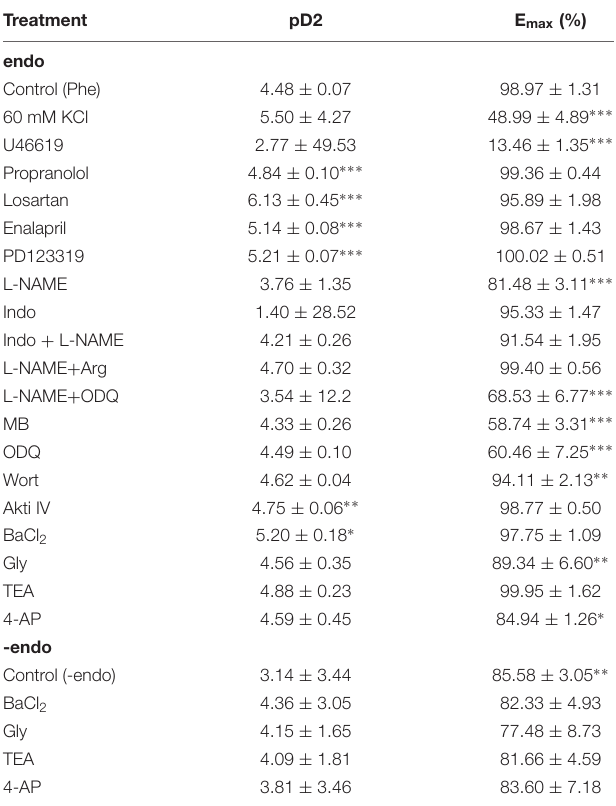
TABLE 1 | Characteristics of THP (1–100 µ M)-induced vascular relaxation under different conditions in intact (endo) and endothelium denudated (-endo) rat aorta.